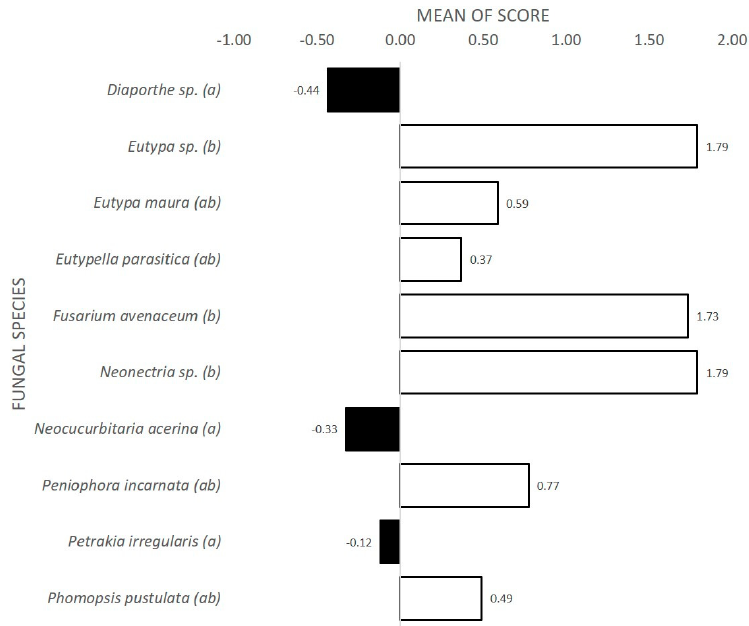
Figure 4. Mean scores ( s , Equation (2), [ − 1.79, + 1.79]) of re-isolation of fungal isolates from dual cultures quantifying the re-isolation success of a challenge isolate in the interaction zone. Bars above zero refer to higher average re-isolation success, while bars below zero refer to lower average re-isolation success of the challenge isolate in competition with E. parasitica . Di ff erent letters in parenthesis, indicate significant di ff erences ( p <